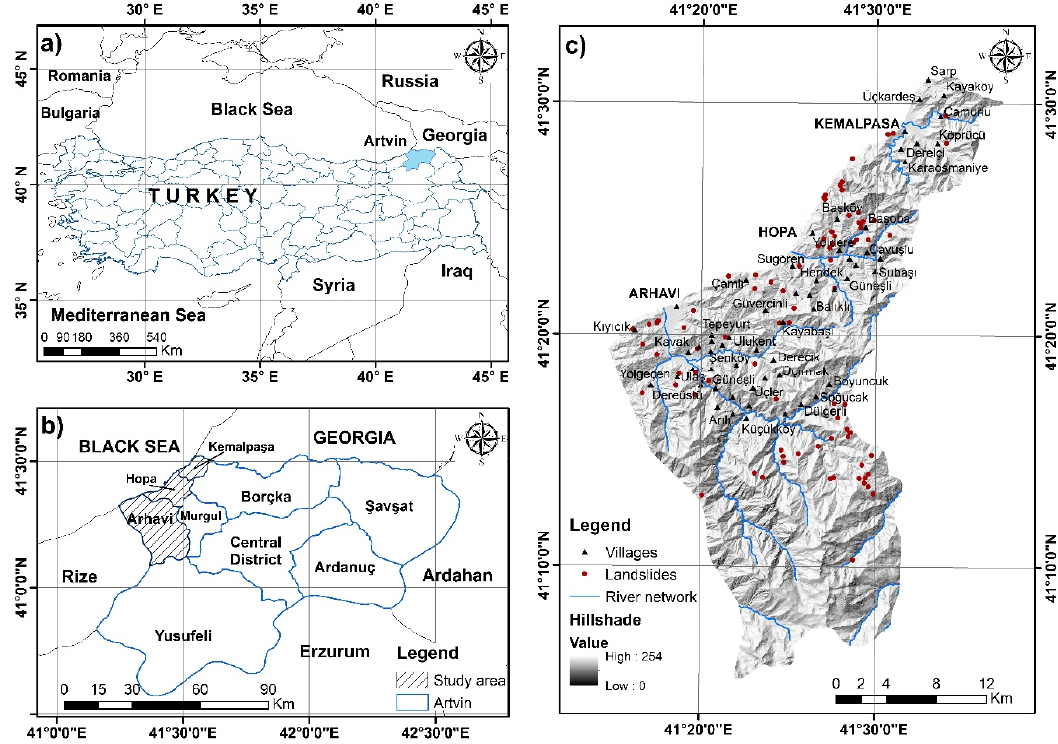
Figure 1. Study area maps ( a ) location map of the study area in Turkey, ( b ) location map of the Artvin region, ( c ) location map showing settlements and landslides in the study area.